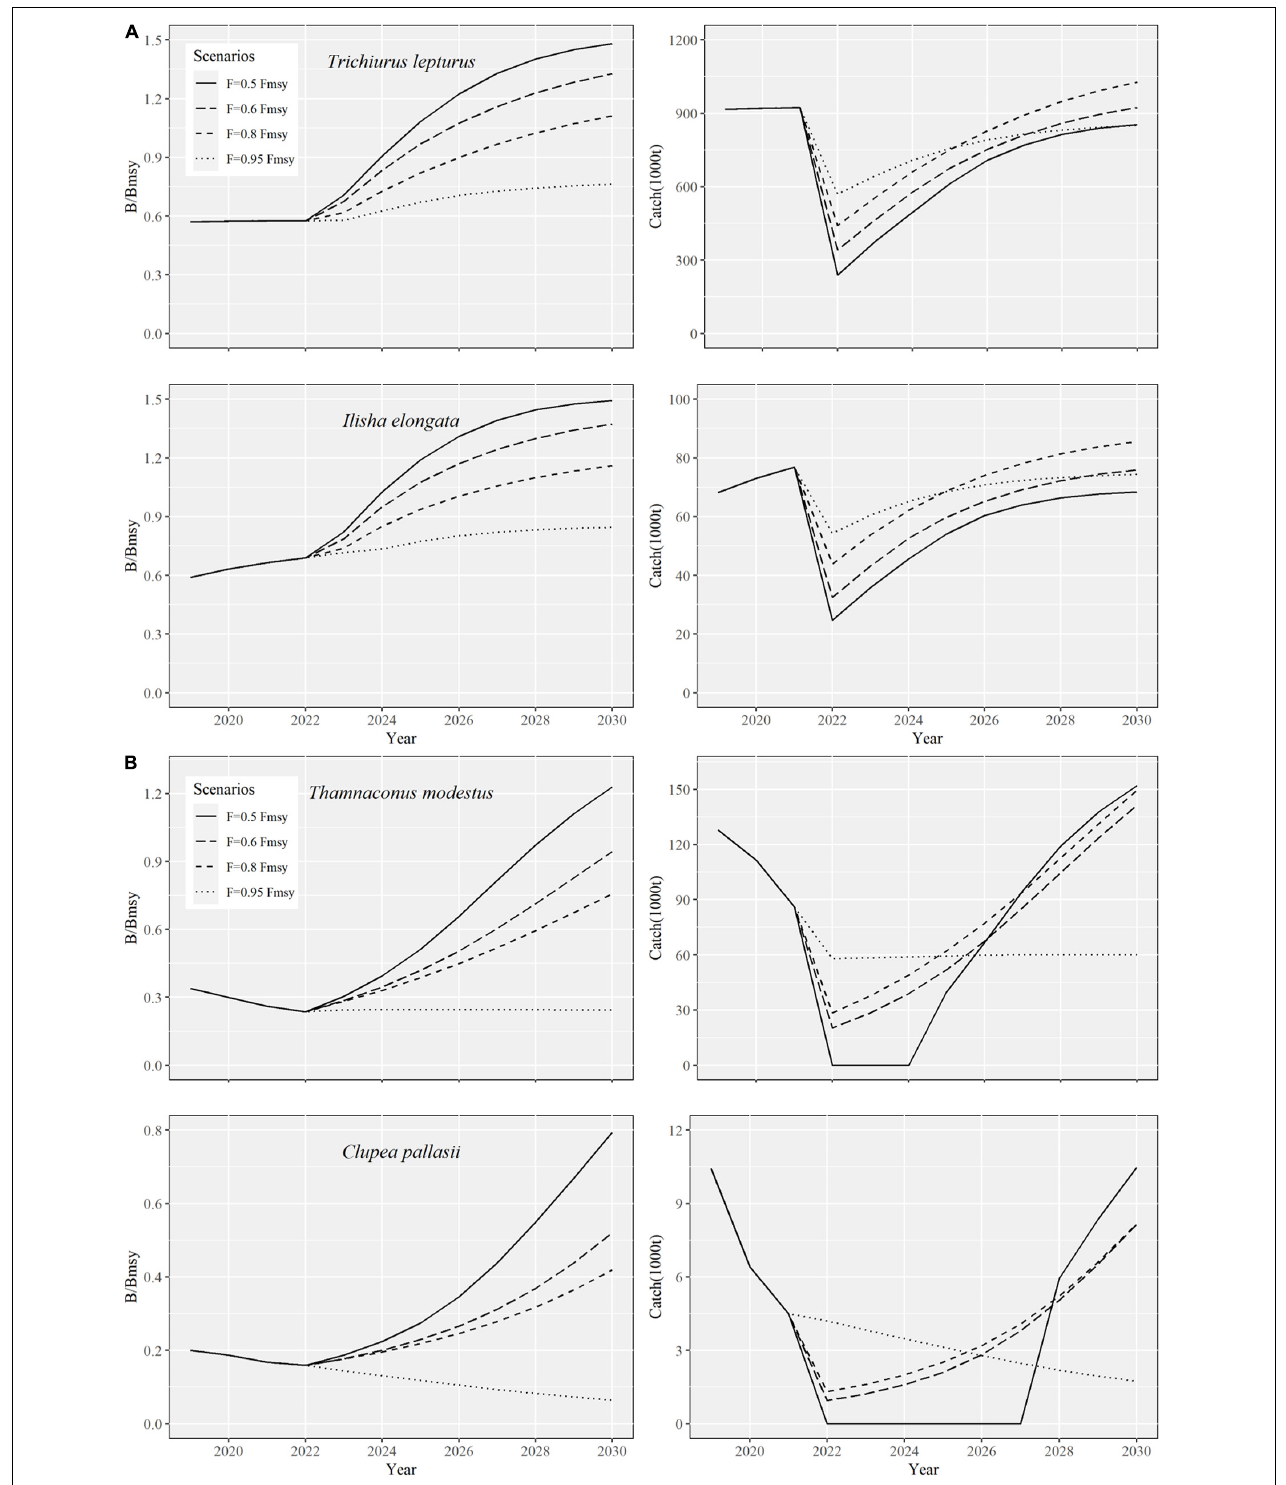
FIGURE 3 | The predicted stock recoveries under four exploitation scenarios (2020–2030), i.e., fishing mortality equals 0.5, 0.6, 0.8, or 0.95 times mortality capable of producing maximum sustainable yields (0.5 F msy , 0.6 F msy , 0.8 F msy , or 0.95 F msy ). The left panels show the recovery trends of the relative biomasses, i.e., ratios of biomass to the biomass capable of producing maximum sustainable yields ( B / B msy ); the right panels show the predicted catch trajectories under the different scenarios. (A) T. lepturus and I. elongata were selected to show the fishery rebuilding trajectories and catch changes; (B) T. modestus and C. pallasii will likely be degenerating under the scenario of